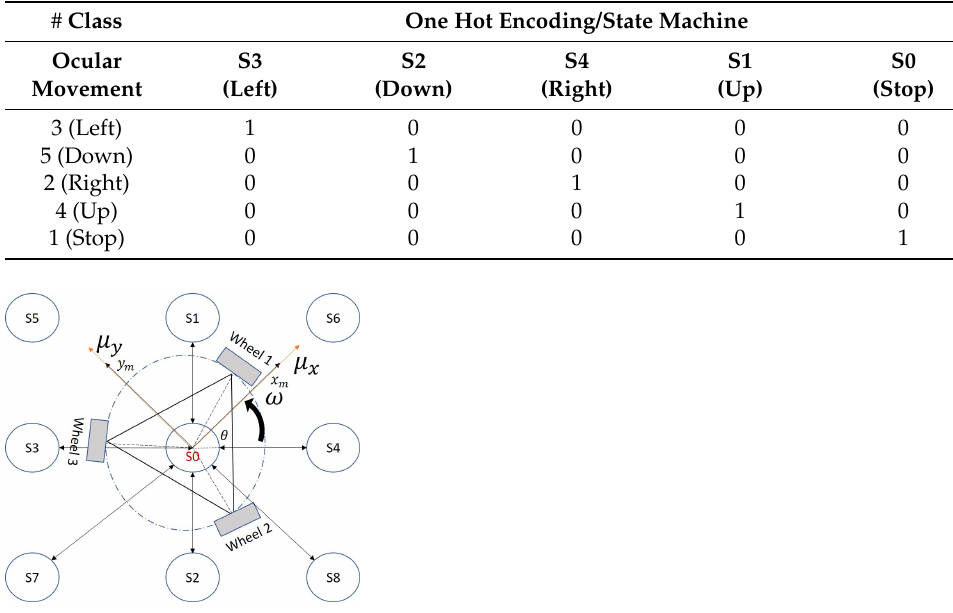
Figure 21. Mealy-type state machine for motion control of an omnidirectional robot; nine states are implemented for the control of a Mealy type machine. S0 to S4 for EOG class from 1 to 5 and S5 to S8 for combined and sequential linear